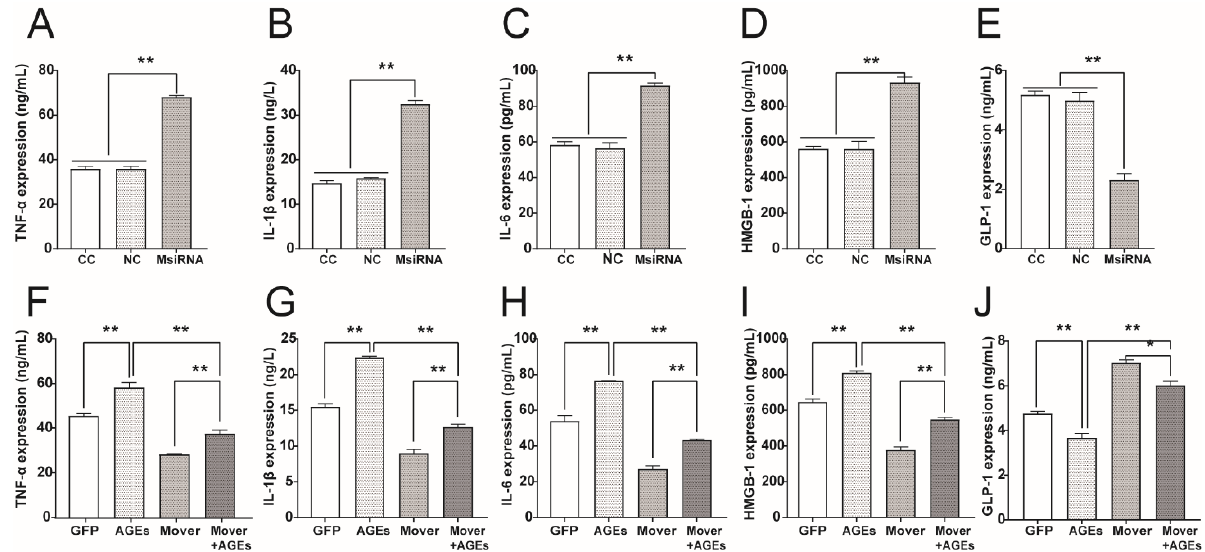
Figure 7. ELISA assay revealing effect of MFG ‐ E8 on DAMPs and pro ‐ inflammatory cytokines in STC ‐ 1. ( A – E ) Effects of MFG ‐ E8 siRNA on HMGB1, TNF ‐α , IL ‐ 1 β , IL ‐ 6, and GLP ‐ 1 levels in STC ‐ 1. ( F – J ) Effects of MFG ‐ E8 overexpression on HMGB1, TNF ‐α , IL ‐ 1 β , IL ‐ 6, and GLP ‐ 1 levels in STC ‐ 1. Results were expressed as the means ± SD from three independent experiments. * p < 0.05, ** p < 0.01. DAMPs: damage ‐ associated molecular patterns.